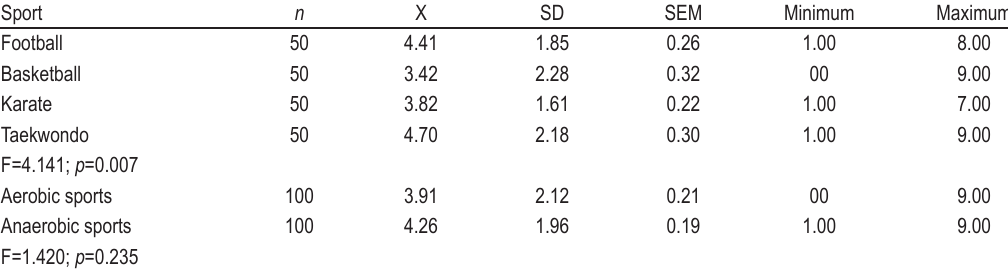
TABLE 5. Average training duration when knee pain or swelling first appeared